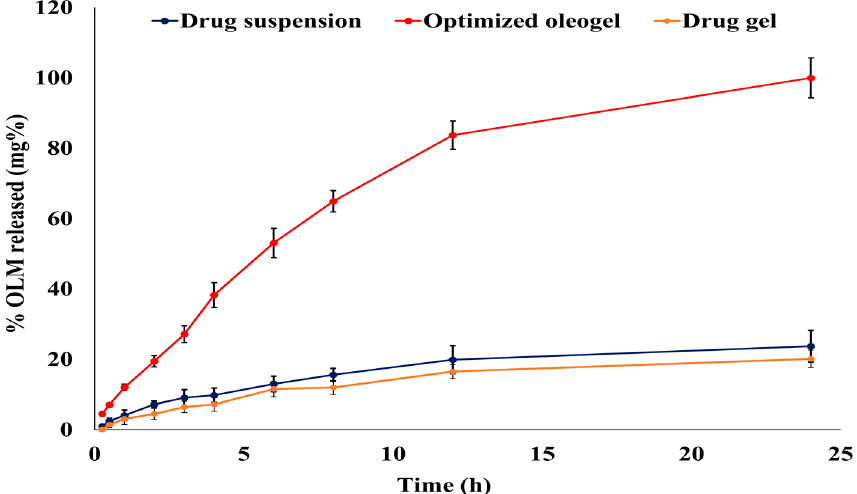
Figure 4. Release profiles of OLM from the optimized oleogel formulation compared to the drug suspension and gel in phosphate buffer (pH 7.4) at 37 °C. Presented data are the mean ± SD (n = 3).